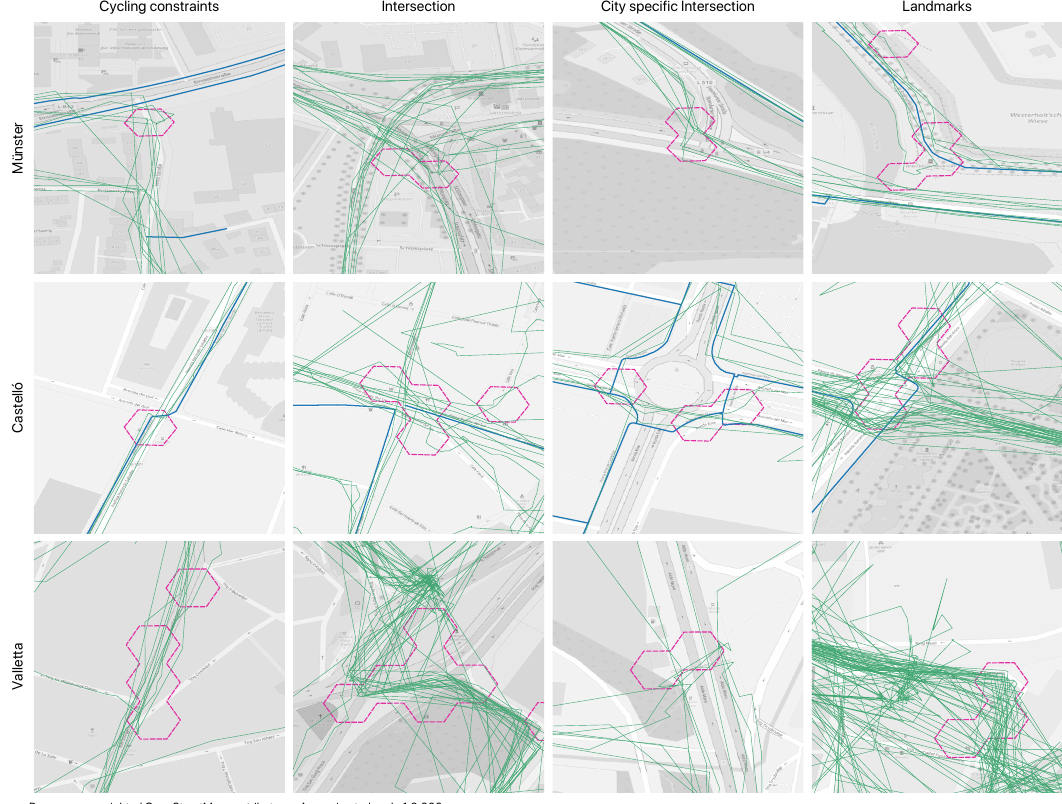
Figure 8. Four typical scenarios for third level